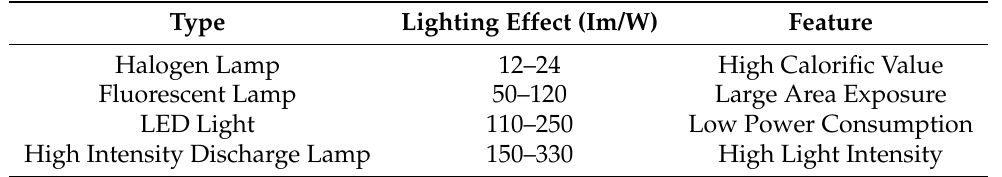
Table 2. The characteristics of light